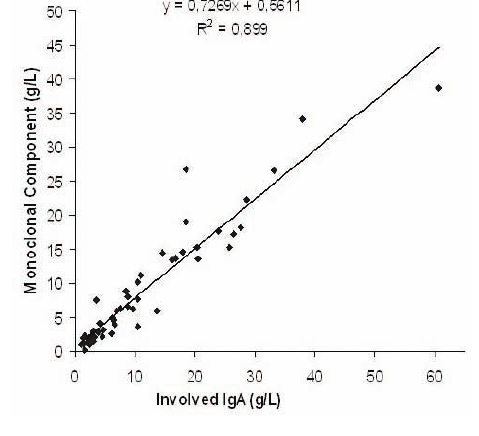
Figure. F63 - QUANTIFICATION OF SERUM IgM k AND IgM λ IN PATIENTS WITH WALDENSTRÖM’S MACROGLOBULINAEMIA (WM): CLINICAL COR-